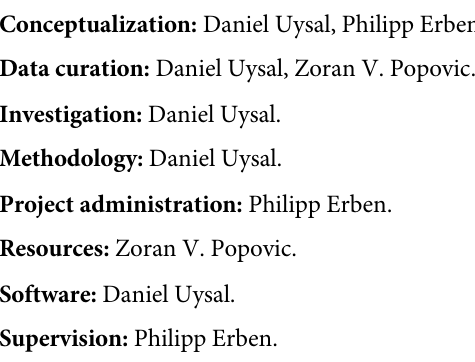
S7 Table. Rate of mutations in AMP and NONAMP patients for RNA_Amplicon_Core. S8 Table. Association of gains at 8q22.2 with other genomic events. S9 Table. Sequence of primers and probes used in the RT-qPCR. S10 Table. Spearman coefficient analysis of genes in the 8q22.2 region. S11 Table. Univariable OS and DFS analysis of COX6C and OSR2 in vitro in a cohort from the university hospital Mannheim (n = 46). S12 Table. Univariable analysis of clinicopathologic features of the cohort from the univer- sity hospital Mannheim (n = 46 patients). S13 Table. Multivariable analysis of OS for COX6C in the university hospital Mannheim cohort (n = 46). S14 Table. Univariable analysis of DFS for OSR2 in the university hospital Mannheim cohort (n = 33). S15 Table. Multivariable analysis of OS and DFS for OSR2 in the university hospital Mannheim